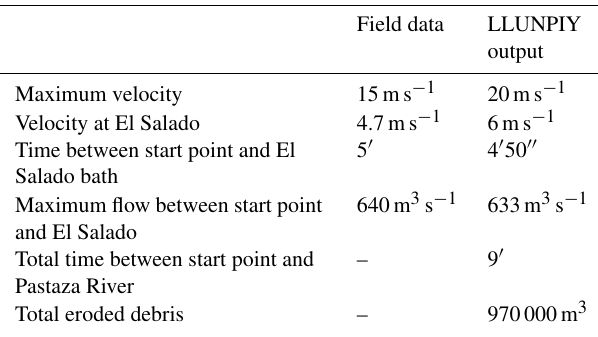
Table 4. Comparison between field and LLUNPIY simulation